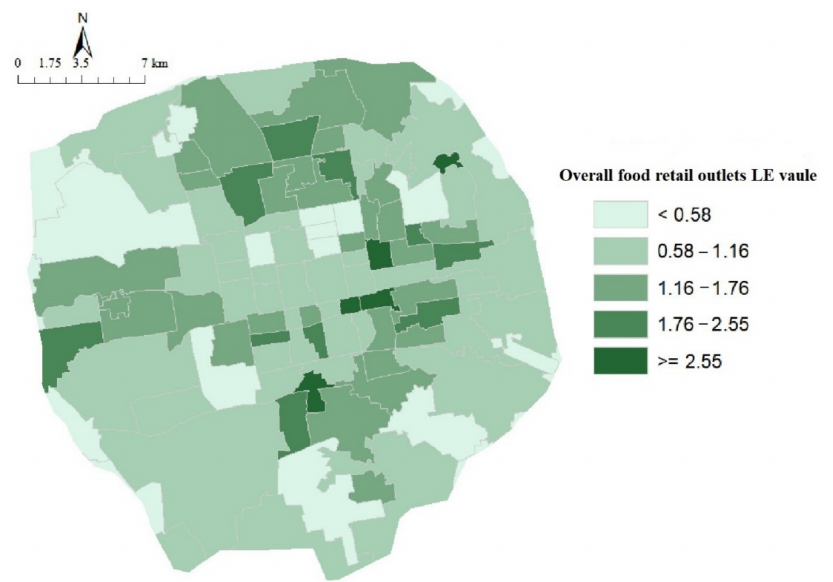
Figure 10. Distribution of the overall food retail outlet locational entropy values for streets within the Fifth Ring Road in